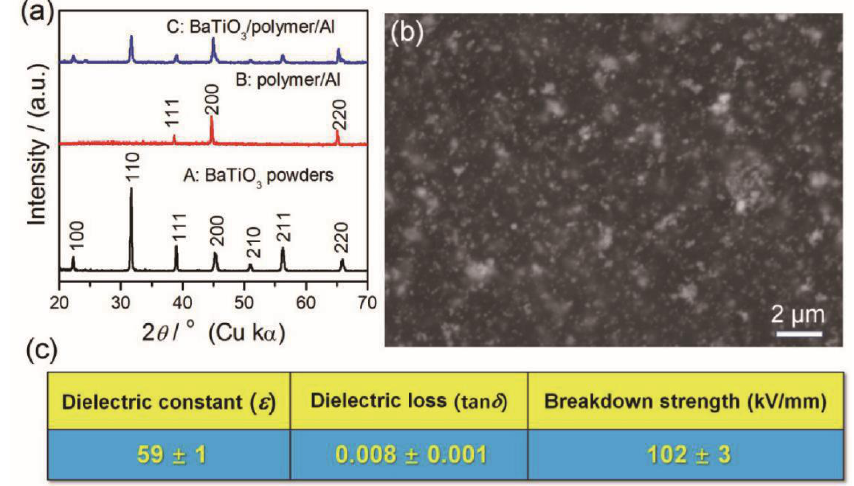
Figure 8. XRD, SEM, and dielectric properties of the typical BaTiO 3 / polymer / Al films (BPA) films with BaTiO 3 nanocrystals (S8): ( a ) XRD patterns (A-BaTiO3 nanocrystals, B-Polymer / Al film and (C)-BaTiO 3 / polymer / Al (BPA) film); ( b ) the typical SEM image of the BPA film; ( c ) typical electric properties of the BPA films.